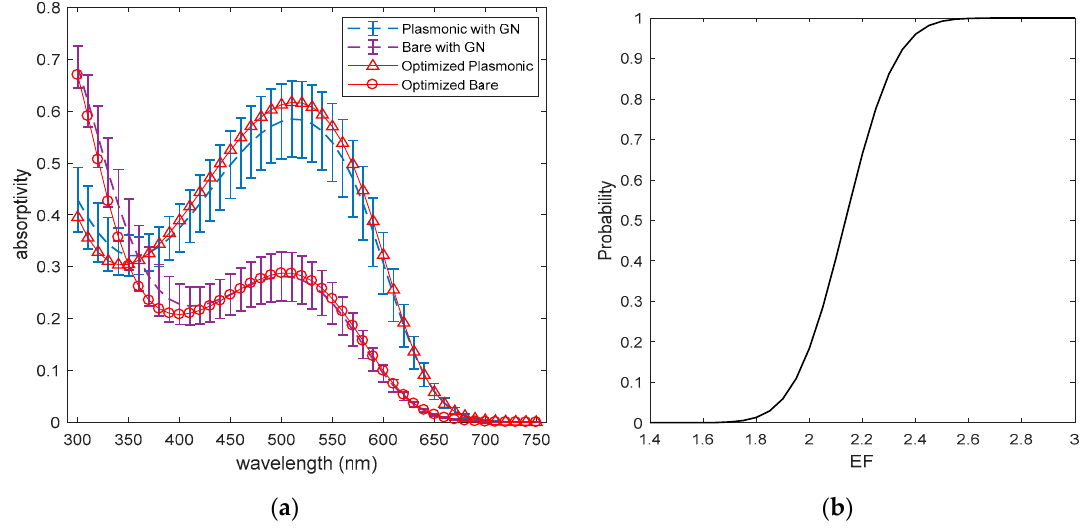
Figure 4. ( a ) Uncertainty of spectral absorptivity and EF to fabrication error modeled by Gaussian noise Spectral absorptivity when Gaussian noise is present with base absorptivity profiles for the geometry optimized by SA (left); ( b ) Cumulated distribution function of EF when Gaussian noise is present (right).